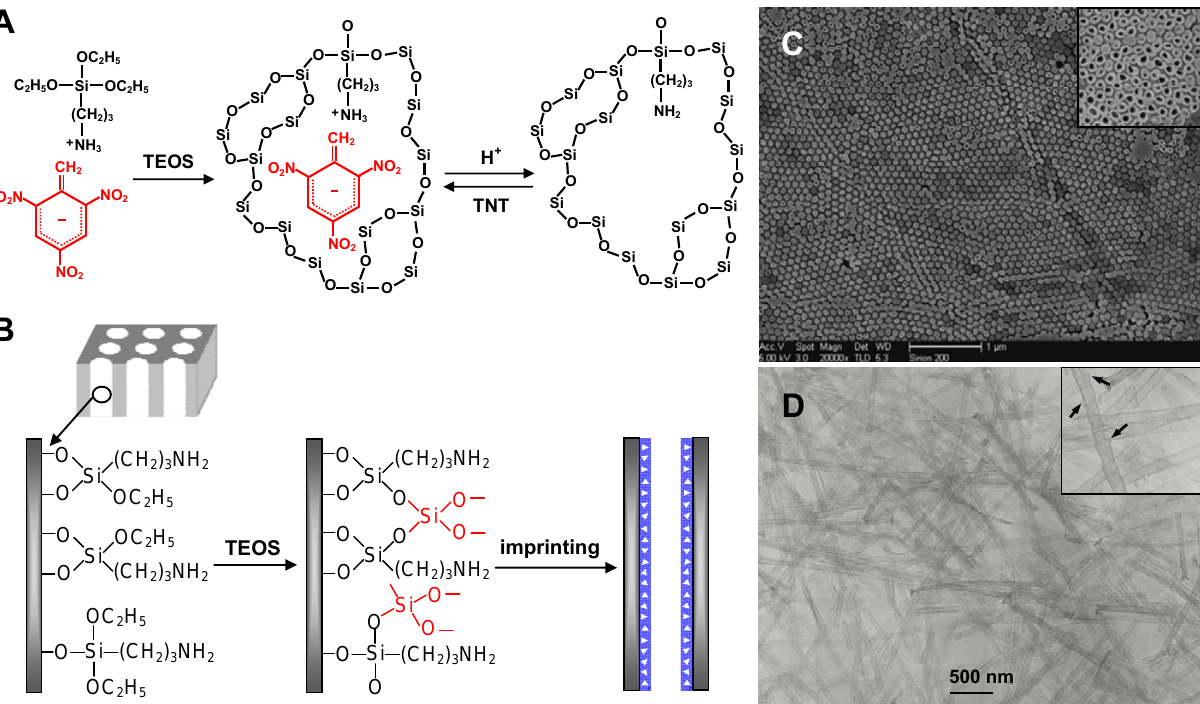
Figure 5. (A) Schematic illustration for the molecular imprinting mechanism of TNT in silica matrix through the anion-cation pair and gelation reaction. (B) The formation mechanism of TNT-imprinted silica nanotubes within APTS-modified porous alumina membrane. (C) Top-view SEM image of the TNT-imprinted silica nanotube array embedded inside alumina membrane after the membrane surface was mechanically polished. (D) TEM image of individual TNT-imprinted silica nanotubes liberated from the alumina pores by dissolving the alumina membranes. Insets are the high-magnification SEM and TEM images, respectively. Reprinted with permission from [15]. Copyright 2008 American Chemical Society. A C B